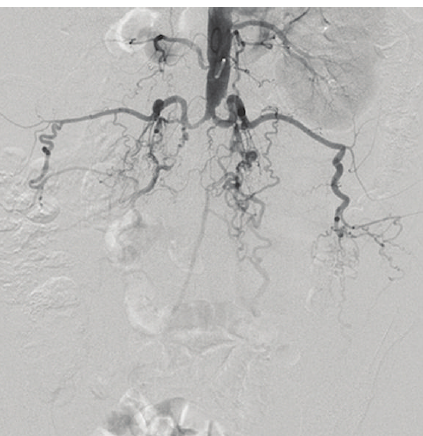
Figure 1: Aortogram showing total occlusion of the distal abdomi- nal aorta and bilateral common iliac arteries.